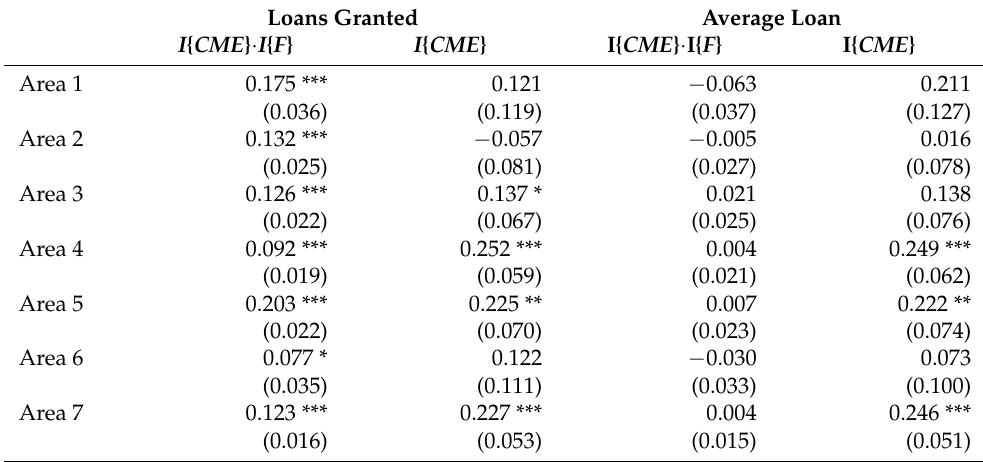
Table 4. Effects by